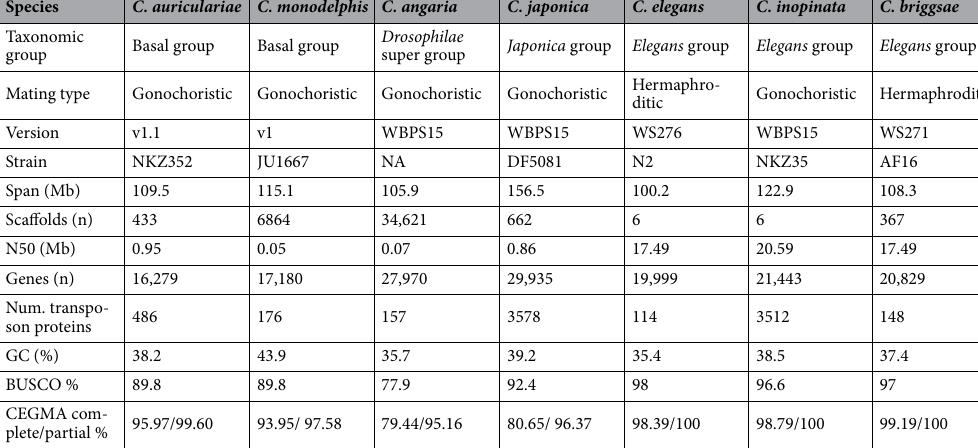
Figure 2. Phylogenetic status of Caenorhabditis auriculariae . ( A ) The combined Bayesian tree inferred from near-full-length SSU and D2-D3 LSU. The substitution model and parameters for SSU and D2-D3 are GTR + I + G (AIC = 16,046.5234; lnL = 8013.261; freq A = 0.2452; freq C = 0.2064; freq G = 0.2661; freq T = 0.2823; R(a) = 1.4800; R(b) = 3.4097; R(c) = 1.9899; R(d) = 0.5864; R(e) = 5.6910; R(f) = 1; Pinva = 0.4188; Shape = 0.4851) and GTR + I + G (AIC = 9579.5820; lnL = 4779.7910; freq A = 0.2163; freq C = 0.2034; freq G = 0.3165; freq T = 0.2638; R(a) = 0.7283; R(b) = 2.7572; R(c) = 1.3283; R(d) = 0.4052; R(e) = 5.6136; R(f) = 1; Pinva = 0.2046; Shape = 0.4580), respectively. Posterior probability values exceeding 50% are given for the appropriate clades. ( B ) Maximum Likehood Phylogeny inferred using a total of 299 one-to-one single copy orthologous by IQTREE v2 with 1000 bootstrap values under LG + F + R5 substitution model.